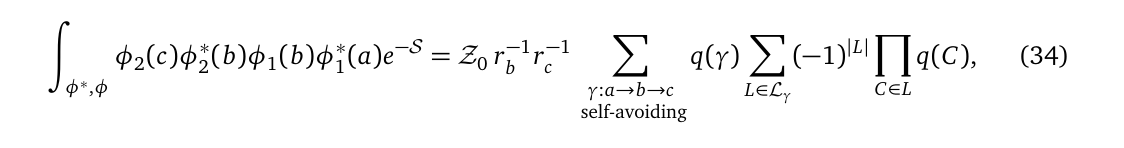
Figure 1: An example of a diagram that contributes to U . Our coloring conventions ) , green for ( φ ) , and red for ( φ are blue for ( φ , φ ∗ , φ ∗ 1 2 1 2 loops do not intersect γ at all. The other loops, as before, give a factor of − 1. We have therefore established